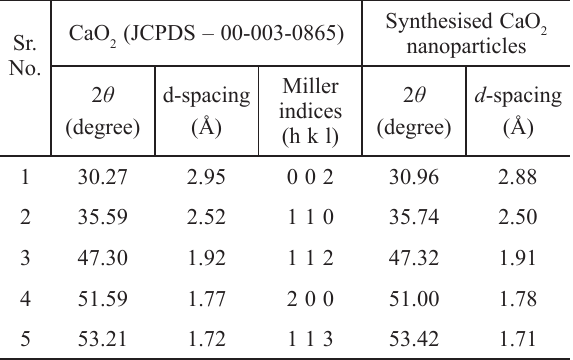
Fig. 2 – X-Ray diffraction pattern of synthesised CaO nanoparticles and standard JCPDS (000-03-0865) of CaO (dotted